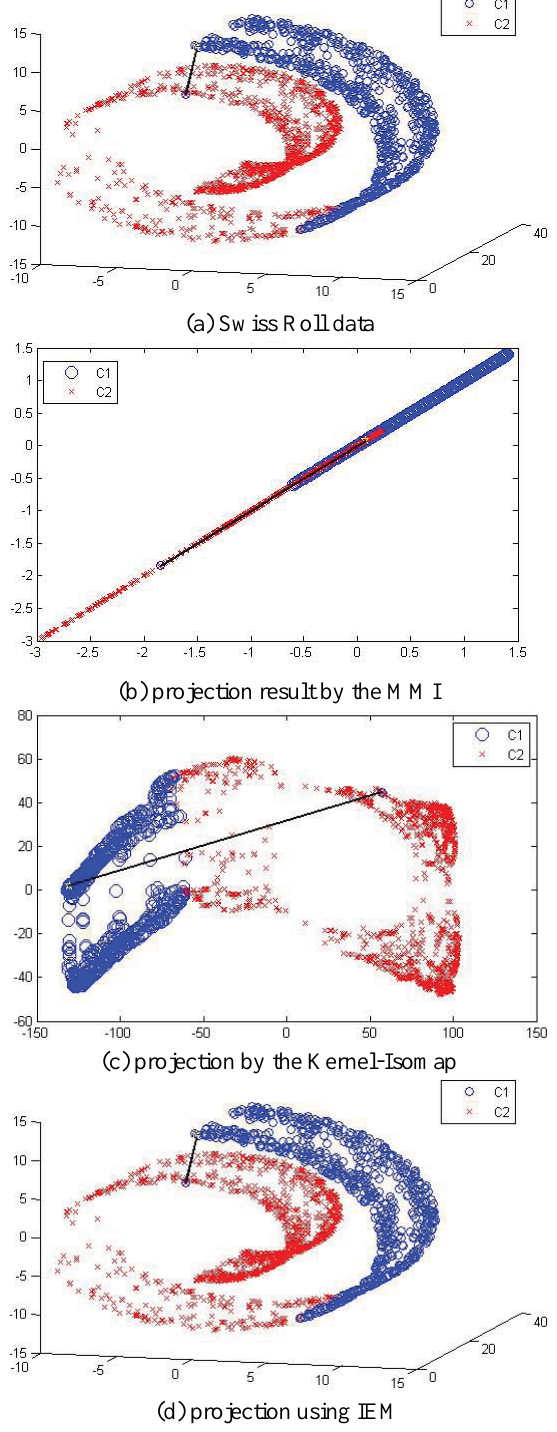
Figure 1. Comparison of IEM with existing methods for the case of Swiss Roll